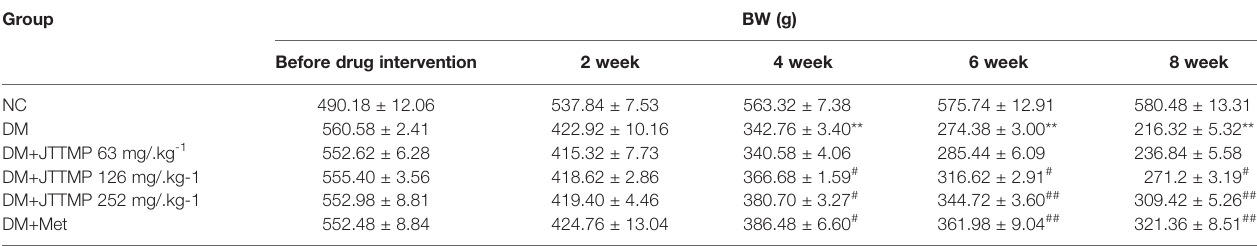
TABLE 1 | The effect of JTTMP on the body weight of diabetic rats induced by STZ ( (cid:1) x ± s, n=6). Group BW (g) Before drug